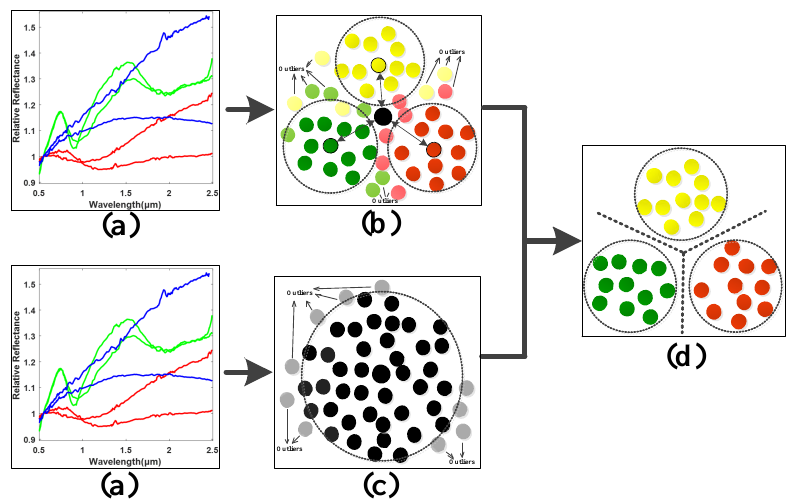
Figure 2. Illustration of the proposed Neighboring Discriminant Component Analysis (NDCA) model. Neighboring between-class scatter matrix S Nb computation: Firstly, calculate the x i for all the samples in training dataset X and find global centroid m b = ( 1/ N ) × ∑ N i = 1 Nb = Rb · N neighboring samples to m b by using between-class neighboring ratio Rb (0 < Rb < 1). Thus, N b = [ N b 1 , N b 2 , . . . , N bc , . . . , N bC ] global neighboring samples X b can be obtained with N bc as the number of the neighboring samples in the c -th class for computing the neighboring between-class scatter matrix. Secondly, compute the local x bcj for the c -th class, and x bcj is the j -th sample in the c -th centroid m bc = ( 1/ N bc ) × ∑ N bc j = 1 class of the neighboring samples X b . Finally, the neighboring between-class scatter matrix is calculated as follows.